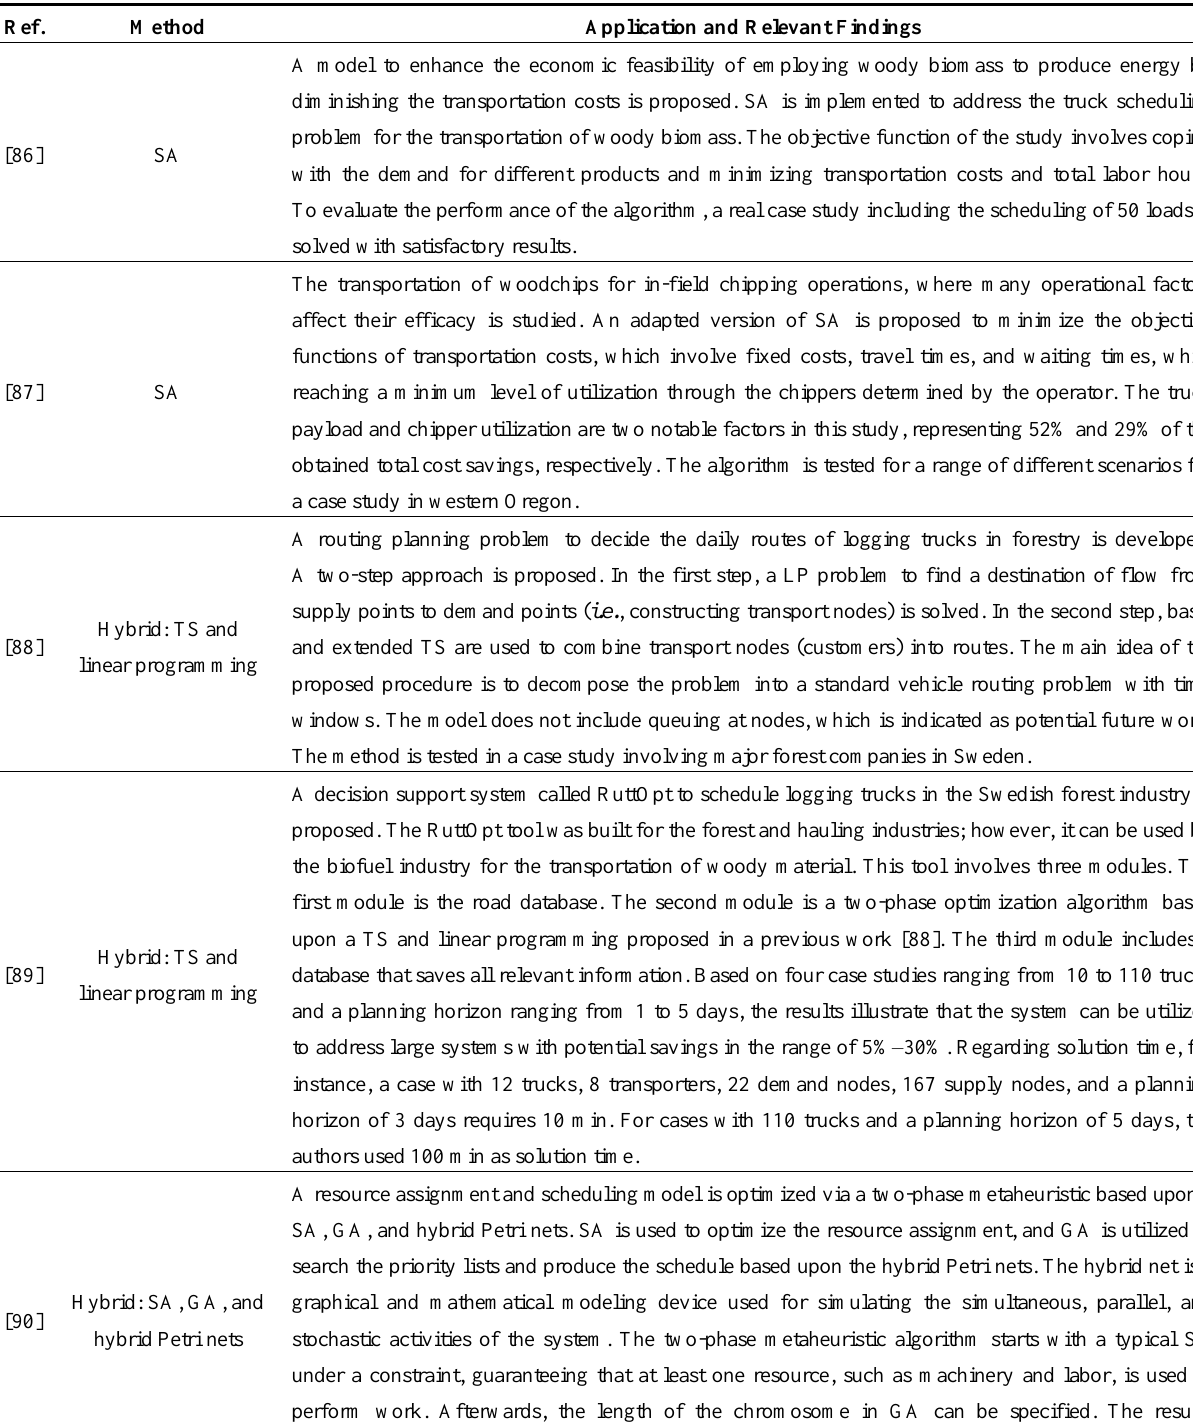
Table 9. Reviewed articles in the scheduling